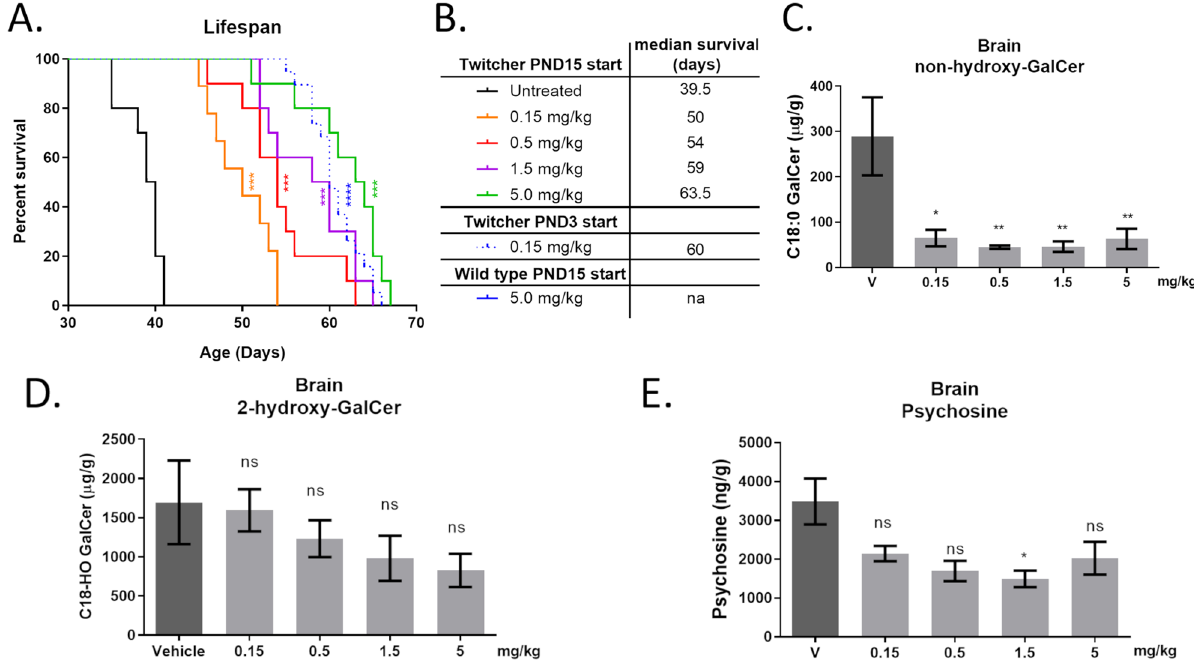
Figure 6. Older Twitcher mice better tolerate S202 but higher doses are required to increase survival. Survival curves of Twitcher mice treated with S202 starting on PND15 ( A ) and median days of survival ( B ). Treating Twitcher mice starting from PND15 with S202 dose dependently reduced non-hydroxy-GalCer ( C ), 2-hydroxy- GalCer ( D ), and psychosine ( E ) (n = 3–4).